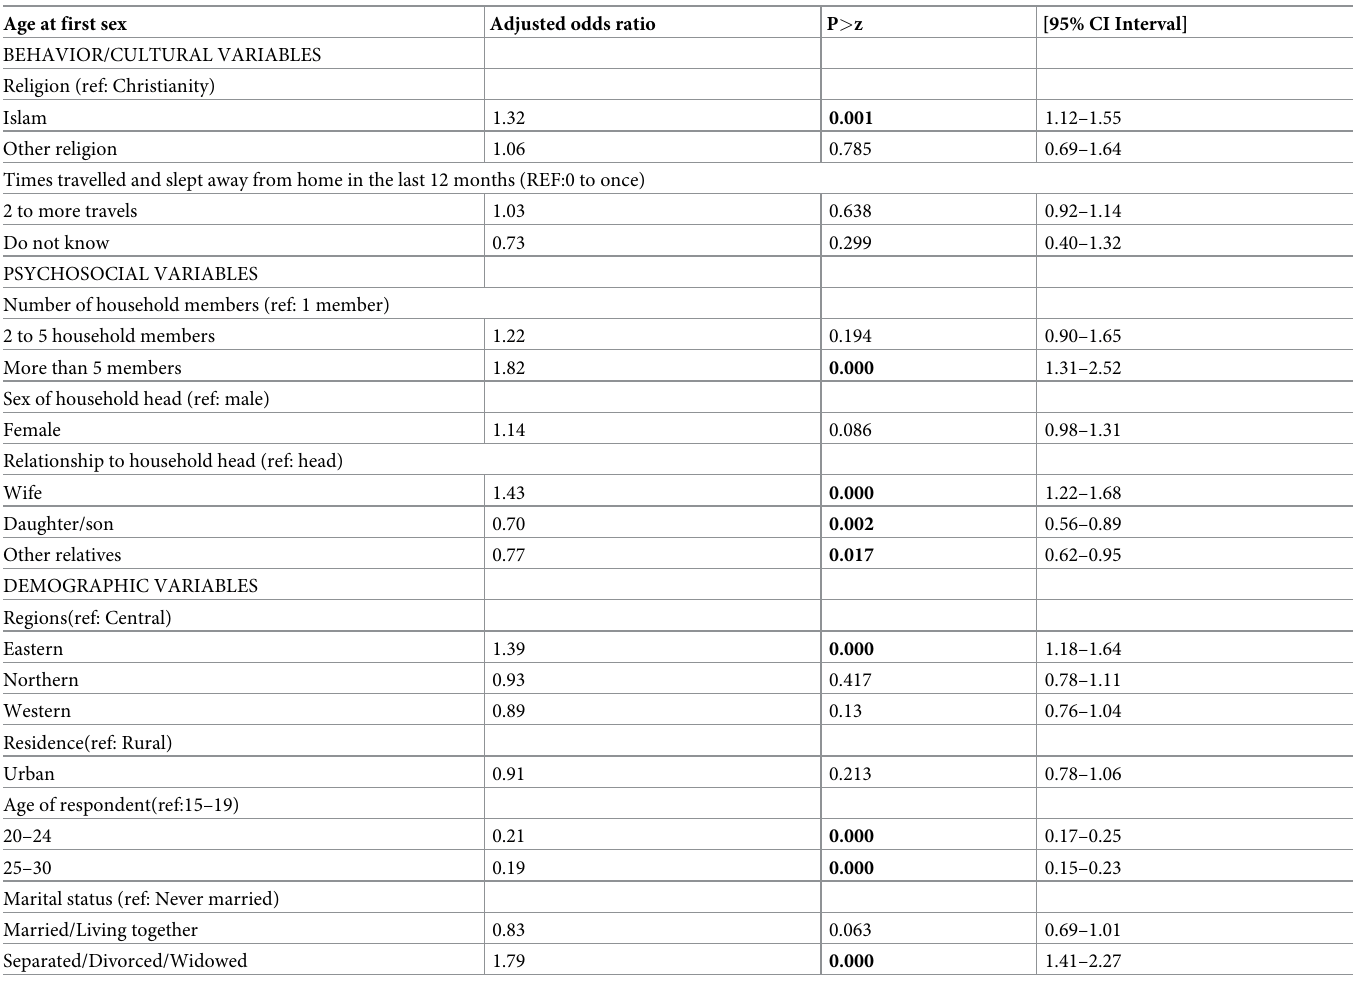
Table 4. Behavior/cultural, psychosocial, and demographic factors related to early age at first